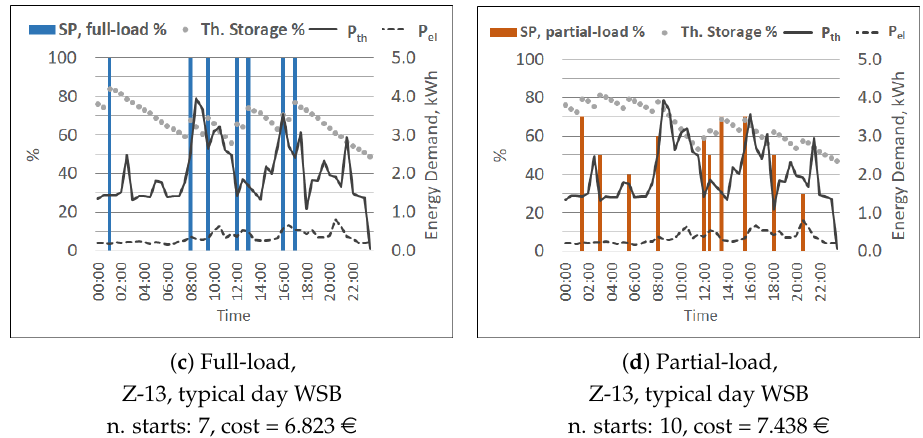
Figure 16. Comparison of the optimal operating profile for two example scenarios: climate zone 15, typical day UWB ( a , b ), and climate zone 13, typical day WSB ( c , d ). On the left, the full-load mode, on the right, the partial-load mode, for a 2-living-unit